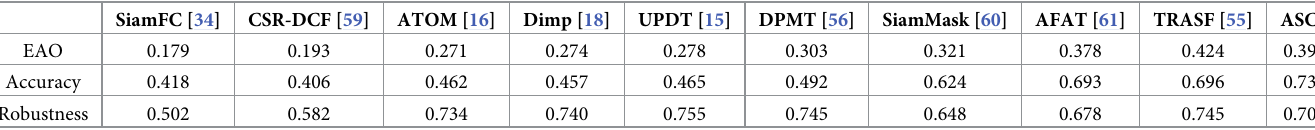
Table 3. Experimental results on VOT2020-ST